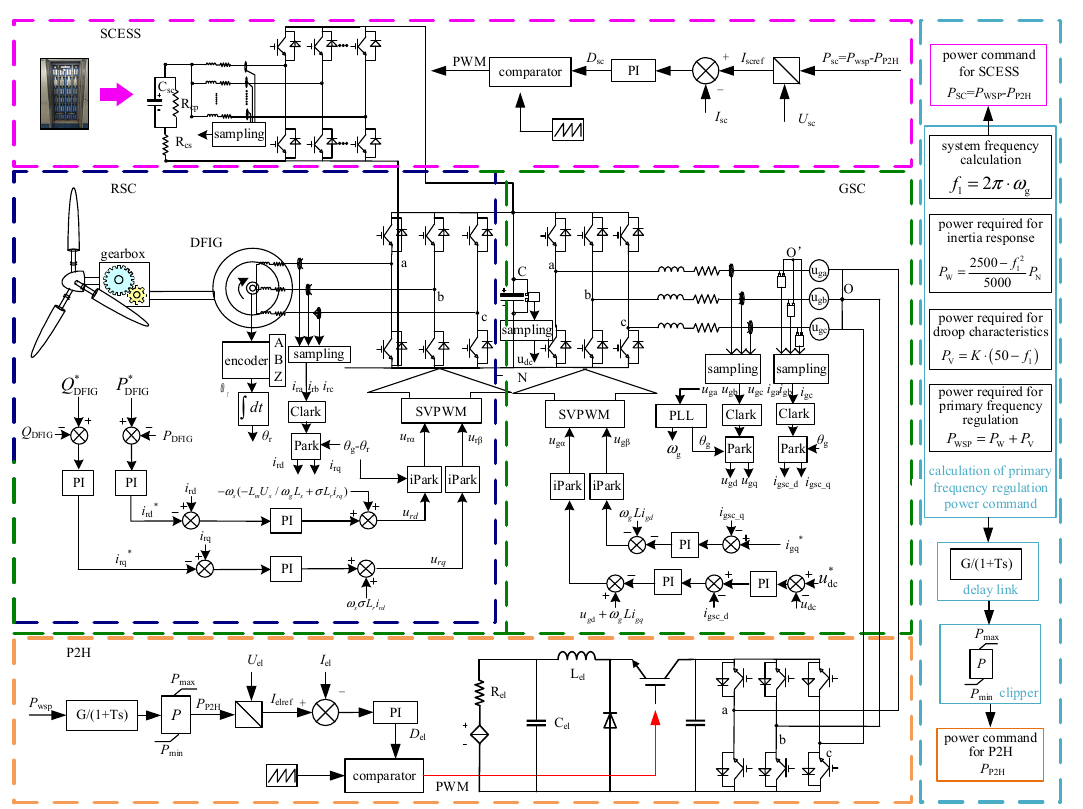
Figure 9. General control block diagram of wind storage hydrogen power station.